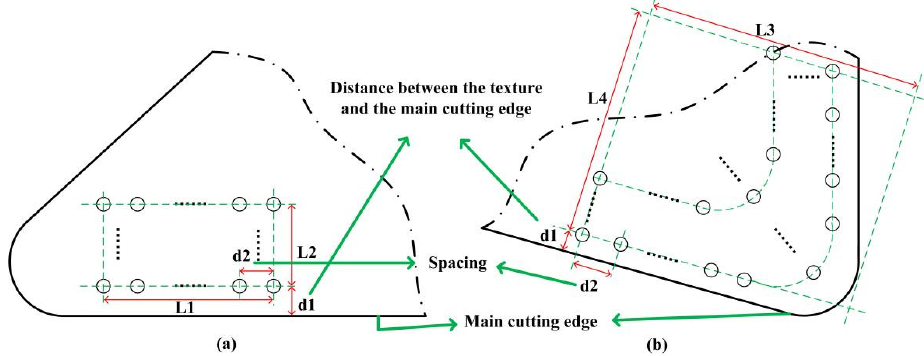
Figure 3. The design of micro-pit texture on PCD tool surface for ( a ) orthogonal cutting and ( b ) micro-turning experiments. Table 1. Tool number and corresponding texture parameters.